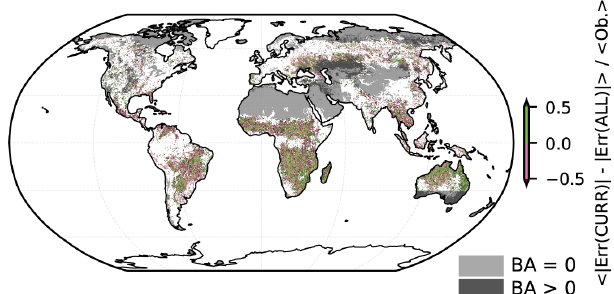
Figure 3. Mean change in out-of-sample prediction error be- tween the CURR and ALL models, relative to mean observations ( < Ob. > ). Green regions have decreased prediction error using the ALL model compared to the CURR model, and vice versa for the purple regions. Areas with high BA (see Fig. 2a) tend to experience lower changes in relative prediction error. Areas with very low or 0 observed BA (see Fig. 2a) are omitted to avoid division by (nearly) 0. Note that sharp data availability boundaries (e.g. in western Asia, southern Australia) are introduced by the AGB dataset. Grey shad- ing indicates regions with fire data availability, but where one or more of the other datasets is not available. Light grey indicates re- gions where mean BA is 0, with dark grey representing regions with non-zero mean